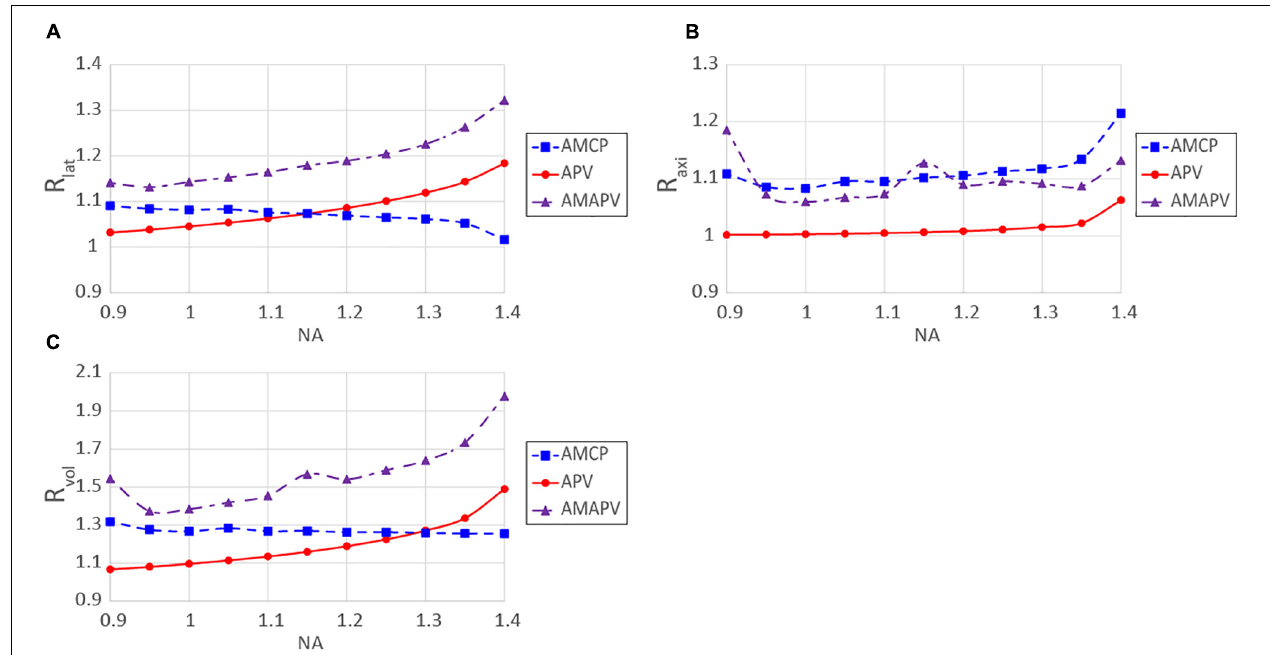
FIGURE 10 | Resolution-enhancement ratios obtained for each NA; (A) R lat , (B) R axi , (C) R vol . The excitation beam was focused through the silicone immersion objective lens.